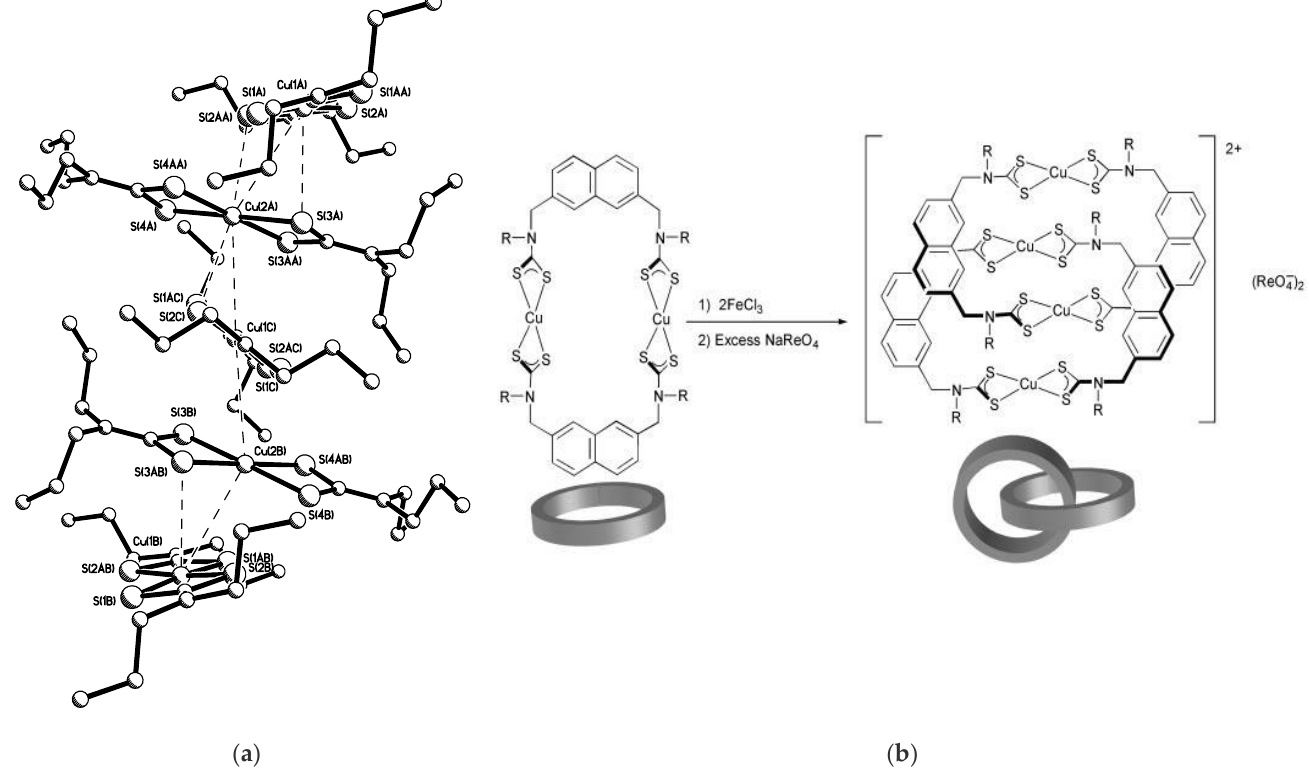
Figure 19. ( a ) The molecular structure of mixed-valence [Cu(S 2 CNPr 2 ) 2 ] 2 [ClO 4 ], and ( b ) the formation and structure of mixed-valence catenane complexes reported by Beer with interlocking Cu(II) and Cu(III) rings. Reproduced with permission from [149,150]. Copyright 2013 Elsevier and 2001 John Wiley and Sons.